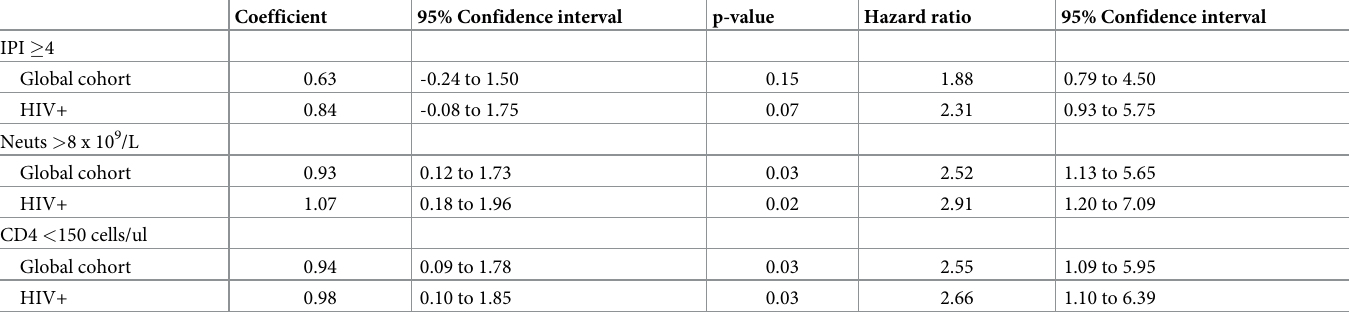
Table 5. Cox proportional-hazards regression analysis for independent associations between the survival time and the IPI, CD4 count and a neutrophil count > 8 x 10 9 /L. Coefficient